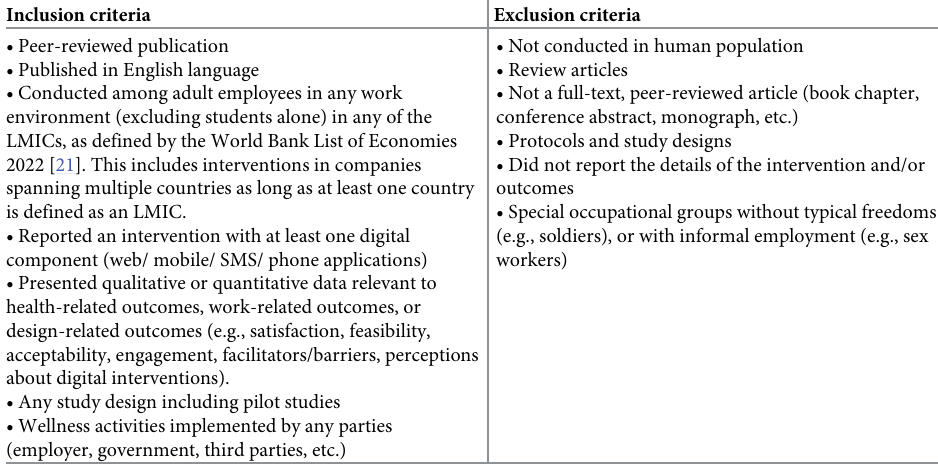
Table 1. Inclusion and exclusion